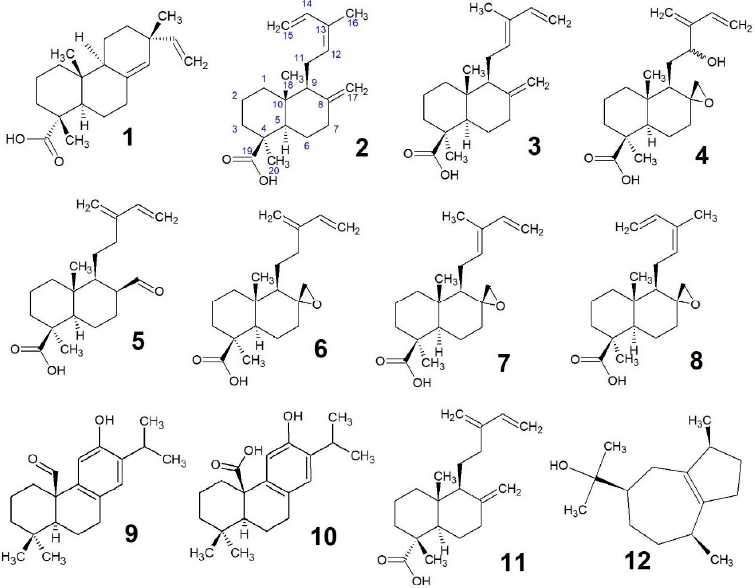
Figure 2. Structures of compounds 1 – 12 , Sandaracopimaric acid ( 1 ), Z -communic acid ( 2 ), E -communic acid ( 3 ), 12-hydroxy-8 R ,17-epoxy-isocommunic acid ( 4 ), 8 S -formyl-isocommunic acid ( 5 ), 8 R ,17-epoxy-isocommunic acid ( 6 ), 8 R -17-epoxy- E -communic acid ( 7 ), 8 R -17-epoxy- Z -communic acid ( 8 ), pisiferal ( 9 ), pisiferic acid ( 10 ), isoozic acid ( 11 ), and guaiol ( 12 Table 3. 13 C and 1 H NMR data for new compounds. 12-hydroxy-8 R ,17-epoxy-isocommunic acid ( 4 ), 8 S -formyl-isocommunic acid ( 5 ), and 8 R ,17-epoxy-isocommunic acid ( 6 ). HMBC, heteronuclear multiple bond correlation.